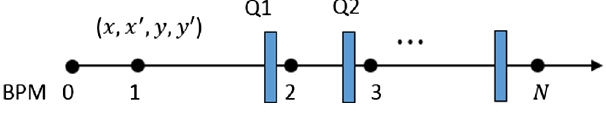
FIG. 3. Configuration for global trajectory